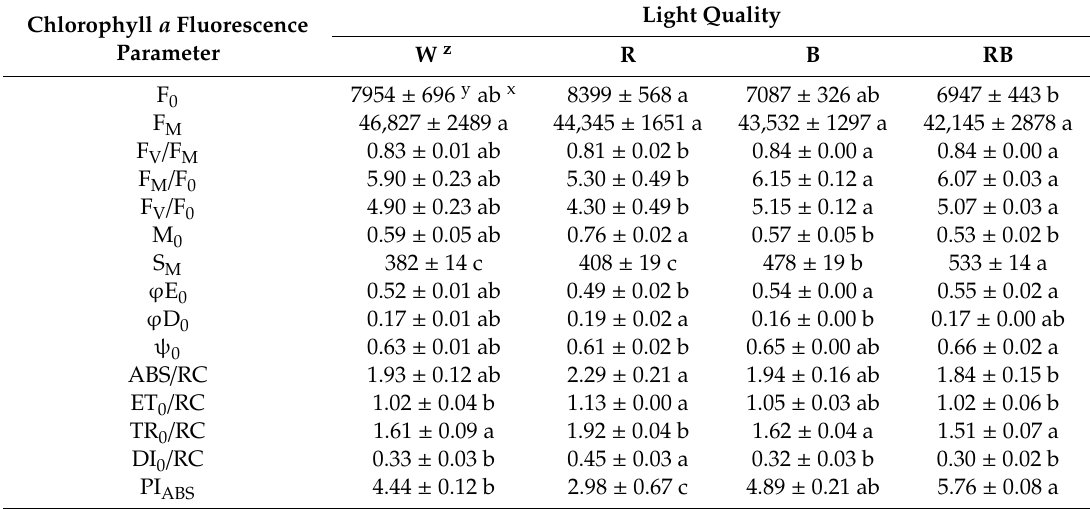
Table 3. E ff ect of light quality on parameters of chlorophyll a fluorescence in leaves of C. triste cultured for 4 weeks.